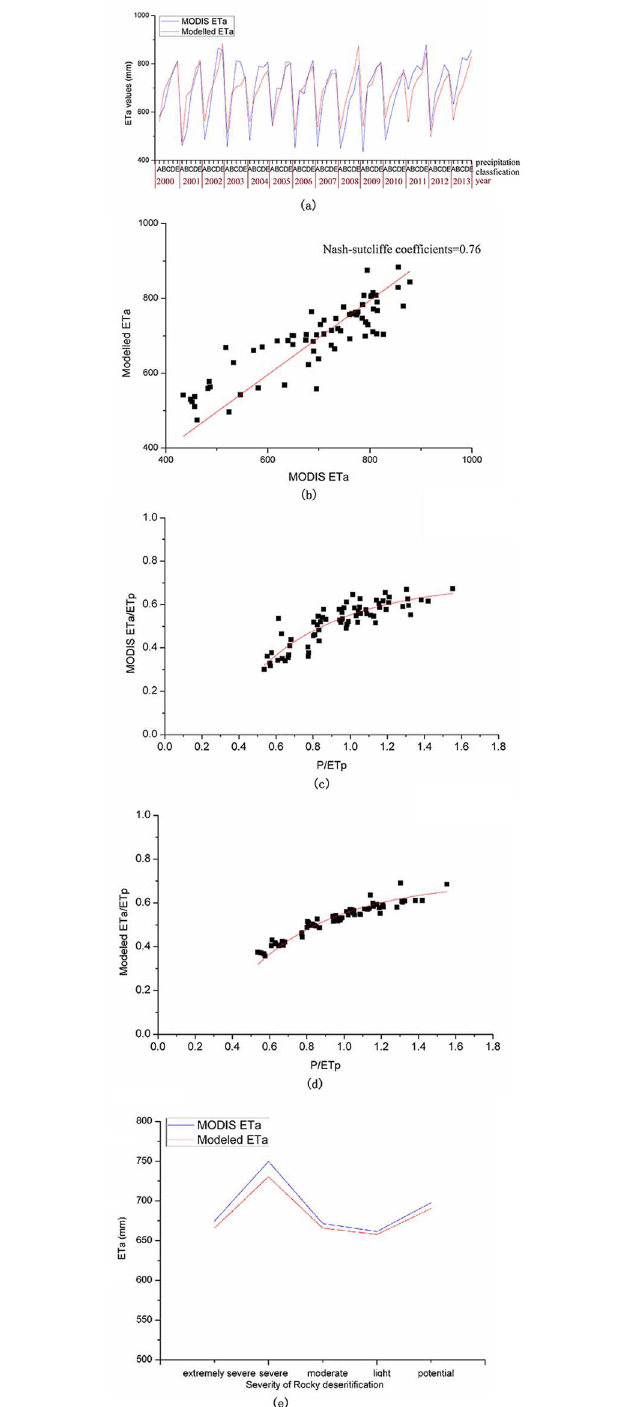
Fig 6. For the given NDVI classification of 0.3 < NDVI (cid:20) 0.4 in the moderate rocky desertification areas, (a) and (b), the comparison of ETa modeling results and the MODIS ETa values, respectively, and the comparison of the relationship between (c) (MODIS ETa)/ETp and (P/ETp), (d) (Modeled ETa)/ETp and the (P/ETp); and (e) the average annual ETa modeling results compared with the MODIS ETa for each rocky desertification